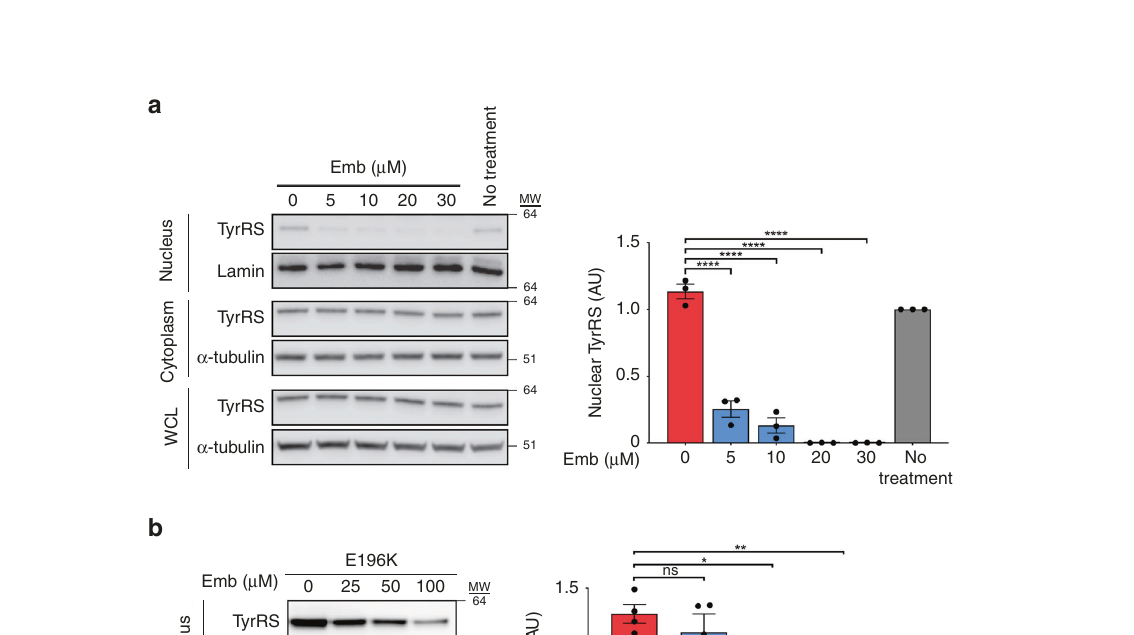
Fig. 3 Mutant TyrRS induces broad transcriptional changes in Drosophila brain tissues. a Volcano plot of log2 fold change versus mean comparing the TyrRS-WT ( nSyb>TyrRS-WT ) with the control condition ( nSyb> + ). b Enriched motifs for the dE2F1 and gem transcription factors identi fi ed in the upregulated and downregulated genes of the TyrRS-WT condition, respectively. E-score, enrichment score. c Volcano plot of log2 fold change versus mean comparing the TyrRS-E196K ( nSyb>TyrRS-E196K ) with the control condition. d Venn diagram displaying the overlap between TyrRS-WT and TyrRS-E196K differentially expressed genes. RF, representation factor. p , associated probability. e Heat map of top 151 differentially expressed genes in the TyrRS-E196K speci fi c 415-gene cluster from brains of Drosophila pan-neuronally ( nSyb-Gal4 ) expressing the indicated transgenes. High expression is shown in red and low expression is shown in blue ( z -scores). f TFs identi fi ed in the TyrRS-E196K speci fi c gene cluster. TFs associated with the downregulated genes are depicted in blue and those associated with the upregulated set are shown in red. The overlapping TFs are indicated in yellow